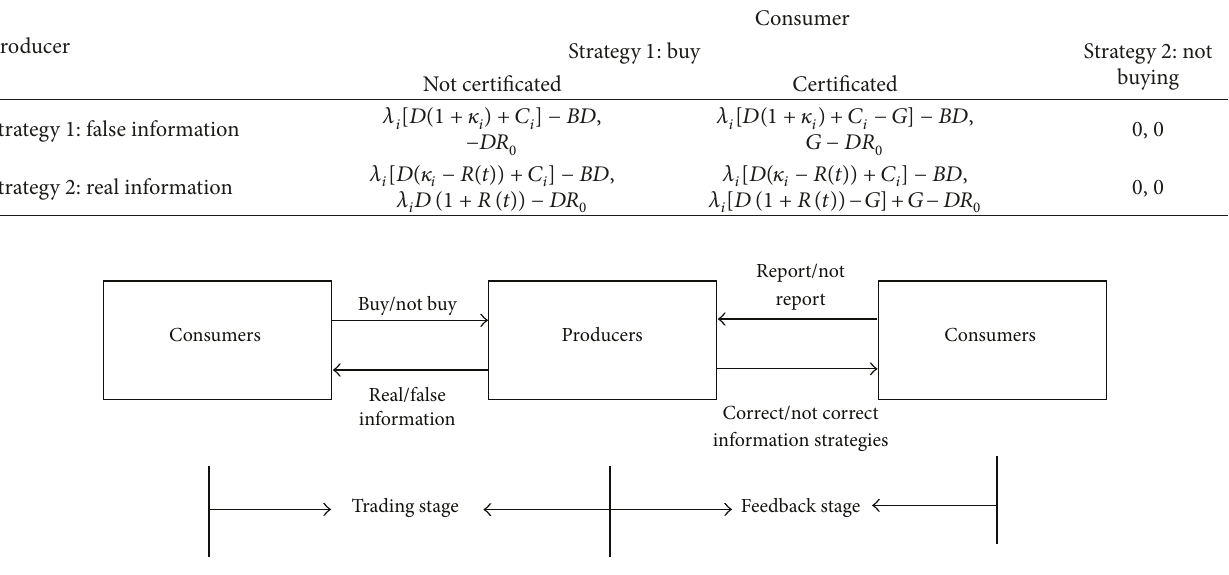
Figure 1: Multistage producer-consumer evolutionary game